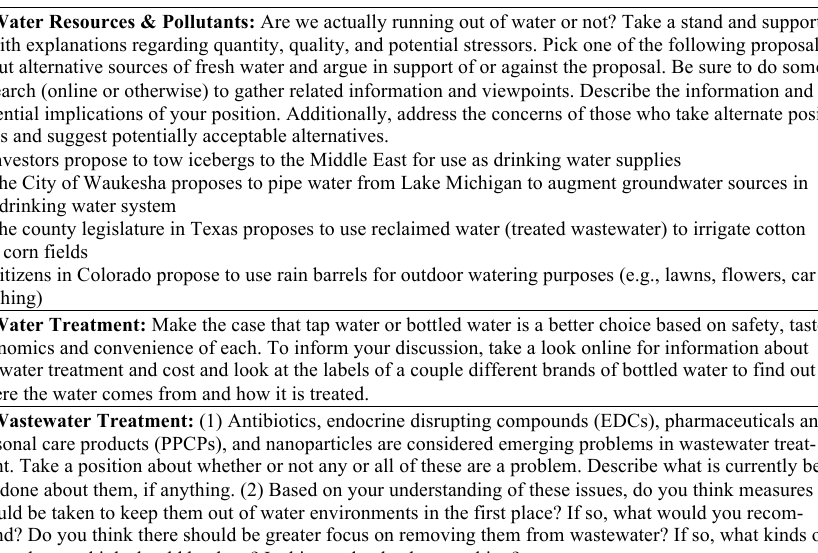
Table 1. Example Discussion Prompts: Introduction to Environmental Engineering